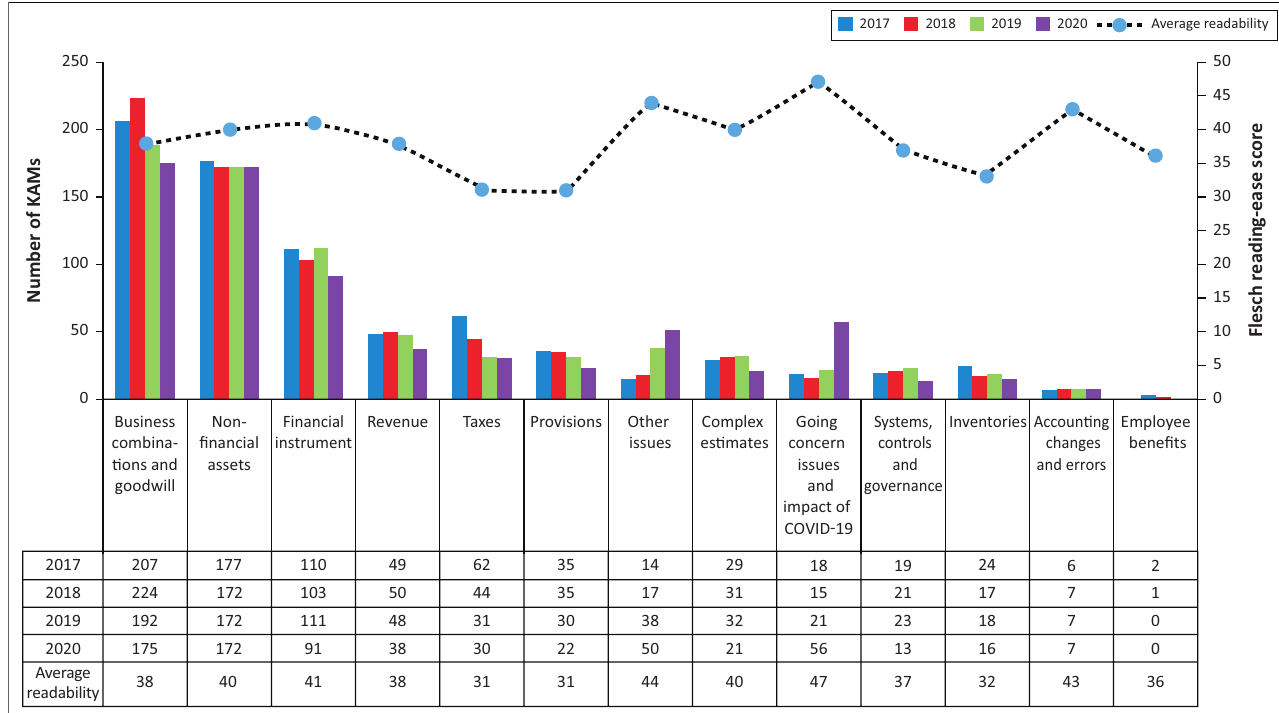
FIGURE 3: Key audit matters reported per year by core